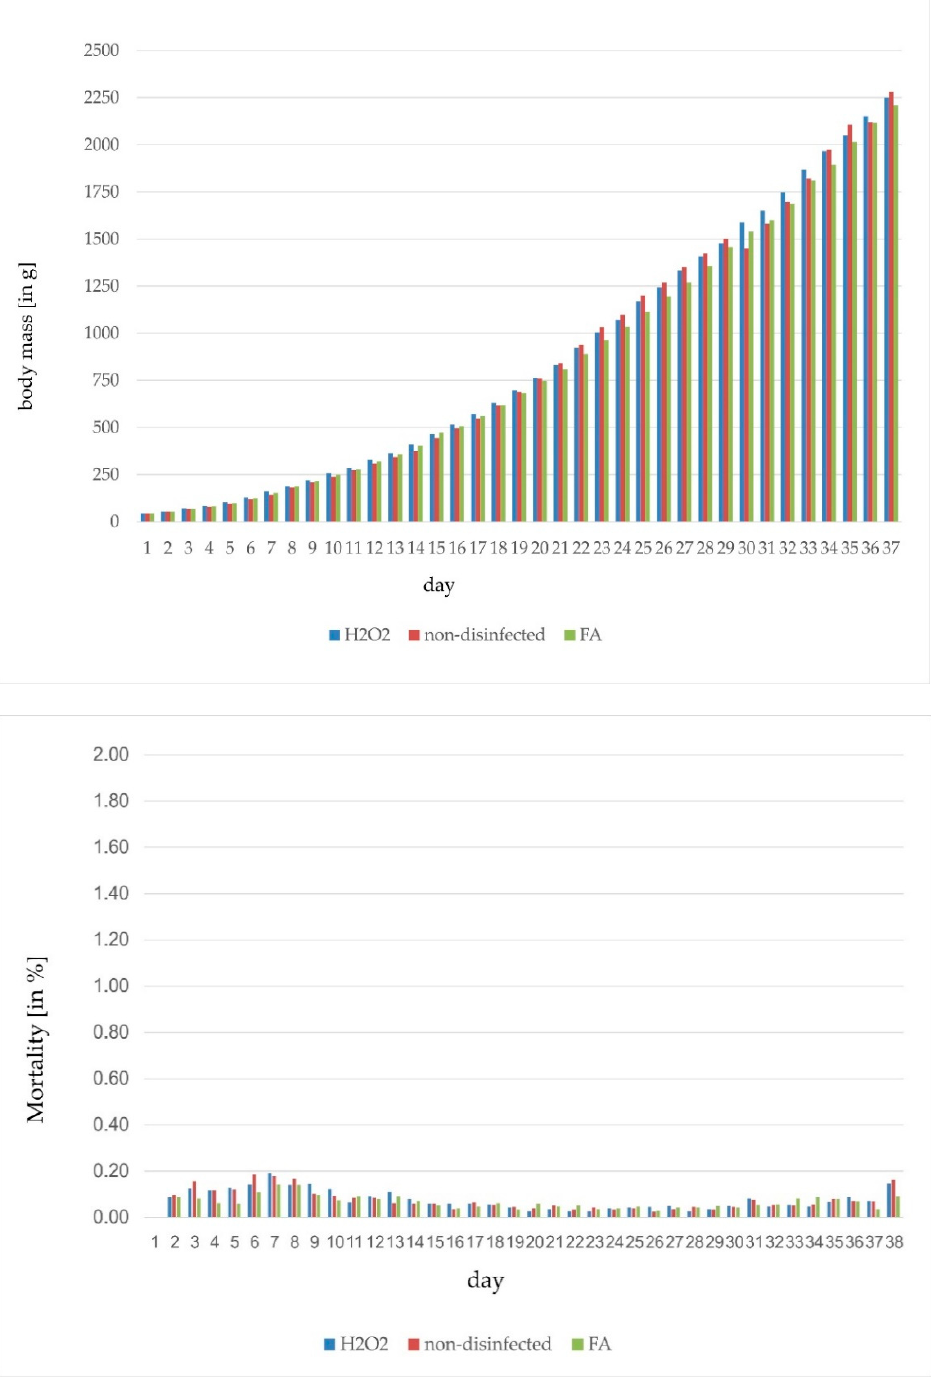
Figure 2. Body mass performance and mortality in trials 3 and 4. Presentation of the body mass performance [g] and daily mortality [%] comparing the H 2 O 2 treated group with the FA treated and non-disinfected group during the fatten- ing period in trials 3 and 4. In these trials, the mean cumulative mortality added up to 2.85% in the H 2 O 2 treated group, 2.49% in the FA treated group and 2.84% in the non-disinfected group on day 37. On slaughter at 37–38 days of age, the number of registered abnormalities was not signif- icantly different. During early slaughter on day 32–33 however, the number of animals with ascites and general infection was significantly higher in the non-disinfected group compared to the group treated with H 2 O 2 ( p = 0.029). For further information see Table 2. Table 2. Results from the slaughterhouse. Trial